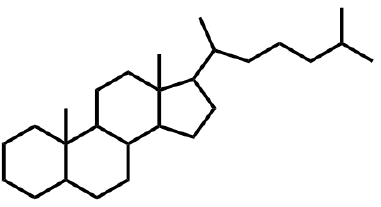
Figure 3. Molecular structure of 5-α-cholestane which reports to the Saturates fraction. Stereochem- istry is omitted for clarity.